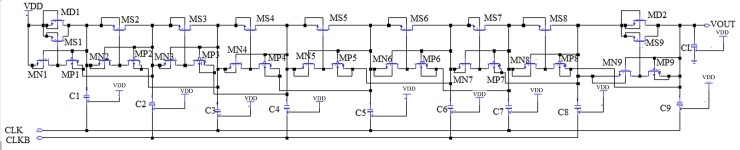
Schematic diagram of the proposed CTS based CP circuit.